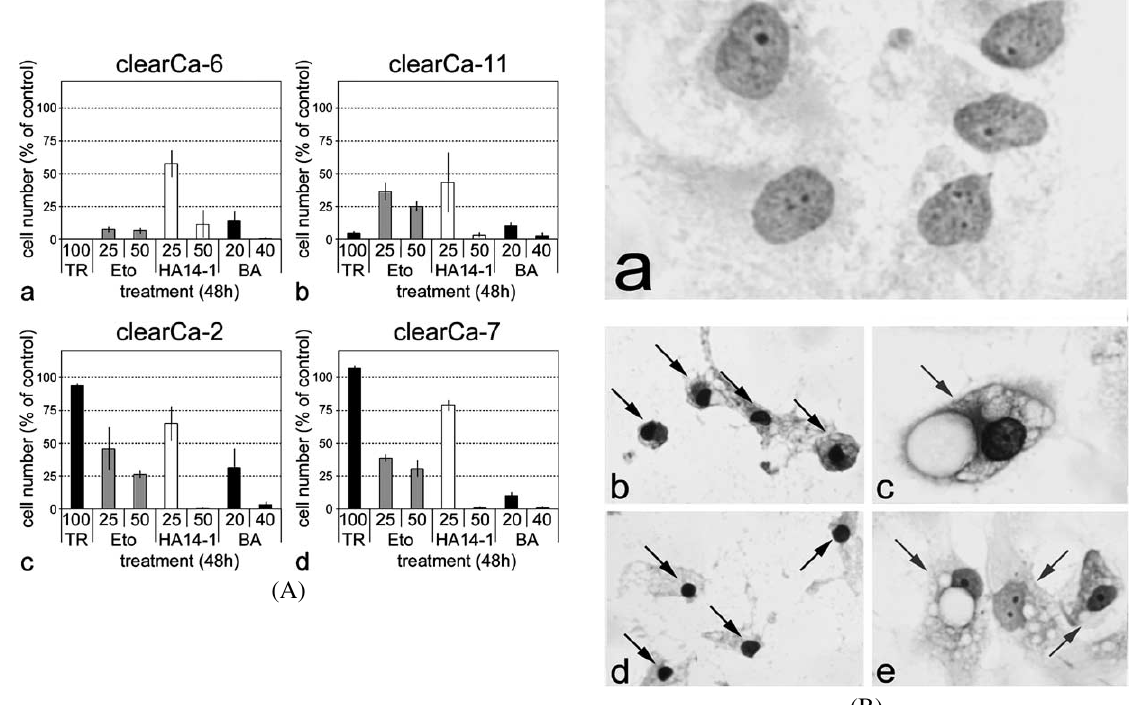
Fig. 1. Cell number and morphological aspects of RCC cell lines after exposure to TRAIL, etoposide, HA14-1 and betulinic acid. (A): Significant reduction of cell number ( p < 0 . 05) after exposure to rhs TRAIL (TR) (100 ng/ml) for 48 h in clearCa-6 and clearCa-11, whereas cell number in clearCa-2 and clearCa-7 remained constant. Significant reduction of cell number ( p < 0 . 05) after exposition with etoposide (Eto) (25 and 50 µg/ml), HA14-1 (25 and 50 µM) and betulinic acid (BA) (20 and 40 µM) in all RCC cell lines after 48 h. (Data represent median ± standard deviation in three independent experiments.) (B): (a) Untreated control of clearCa-11 cells. (b and d) Marked increase of apoptotic figures after exposure to TRAIL (b) and HA14-1 (d) (black arrows). (c and e) Marked increase of necrotic cellular changes with disintegration as well as intracellular swelling of organelles and without chromatin condensation after exposure to etoposide (c) and betulinic acid (e) (grey